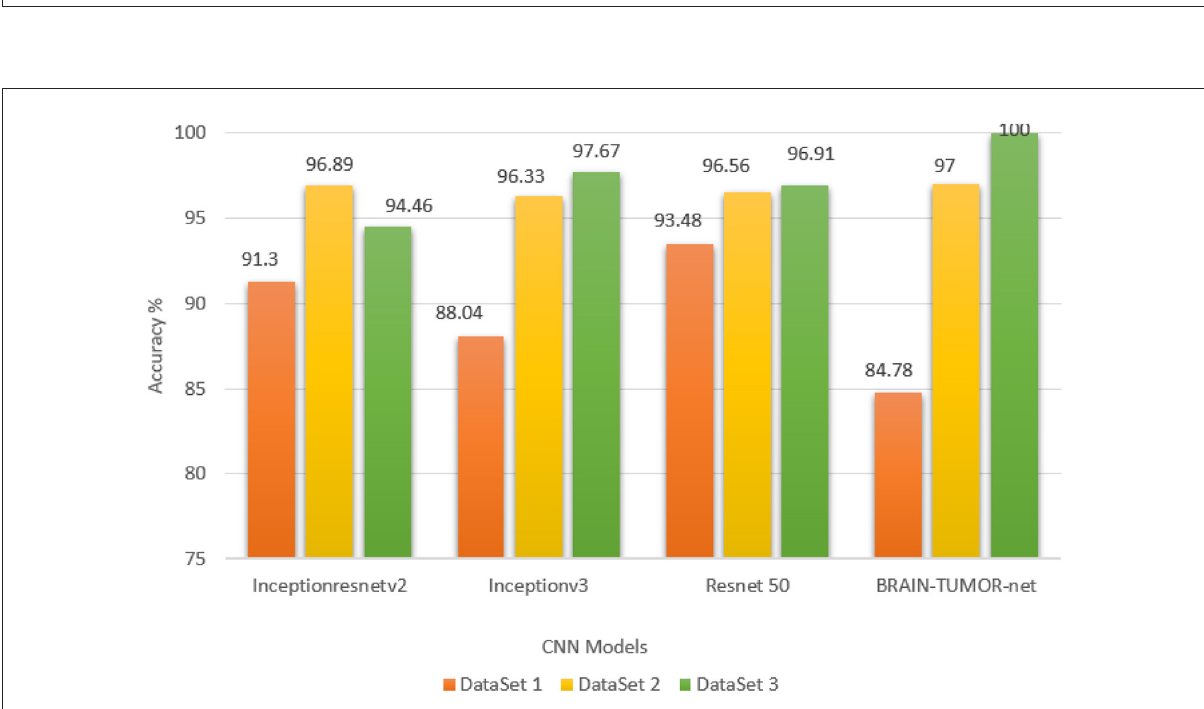
FIGURE9 Accuracy values for different CNN models on the three MRI brain tumor